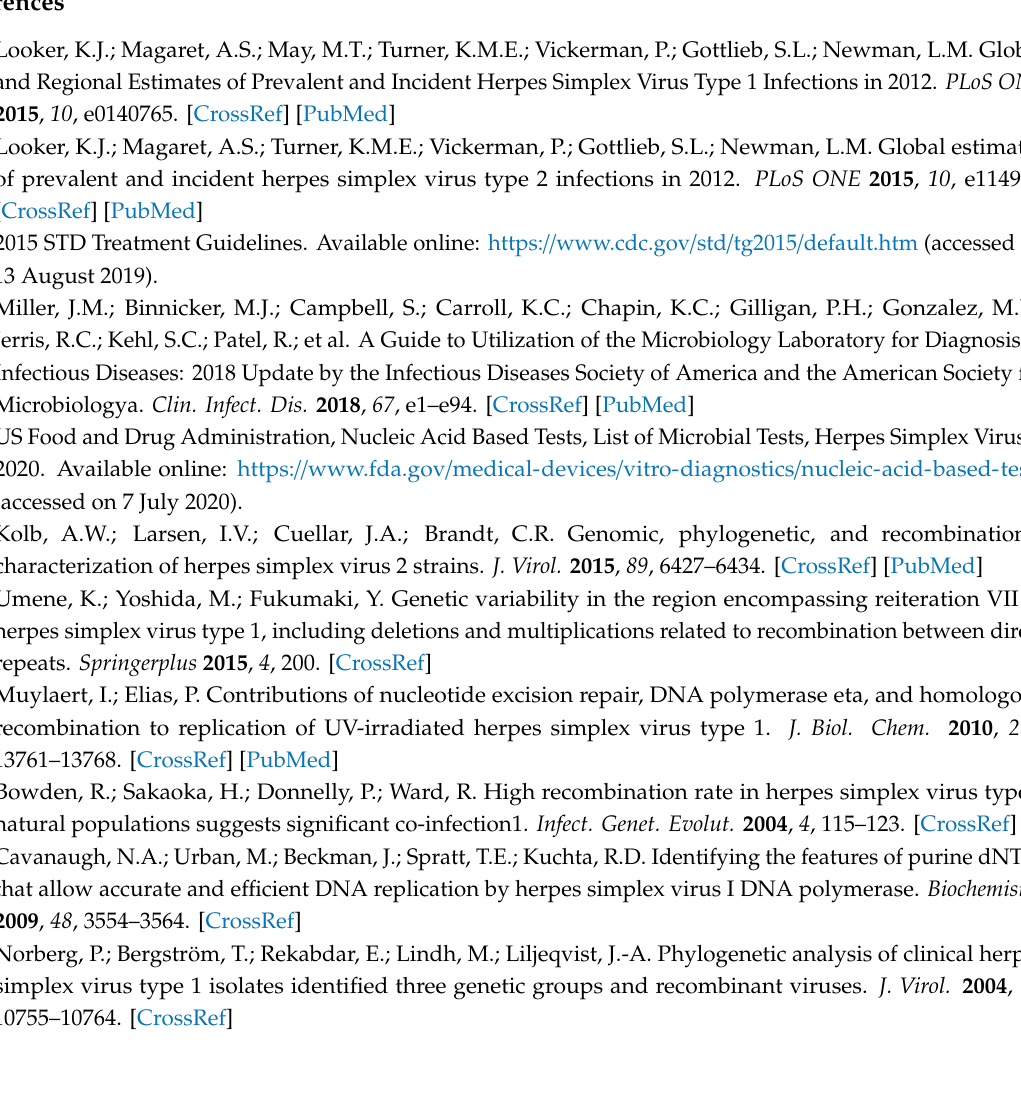
Supplementary Methods, Supplementary Figure S1: Postfusion protein conformation of glycoprotein B of HSV-1. Supplementary Table S1: HSV genes with known HSV-1 x HSV-2 recombination